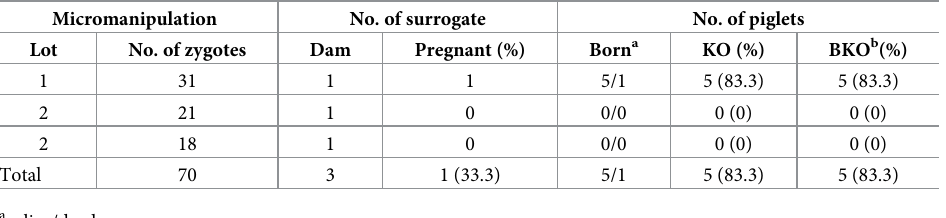
Table 2. Generation of CMAH knockout (KO) pigs by direct microinjection of sgRNA/Cas 9 mRNA into the cyto- plasm of pronuclear newly fertilized porcine